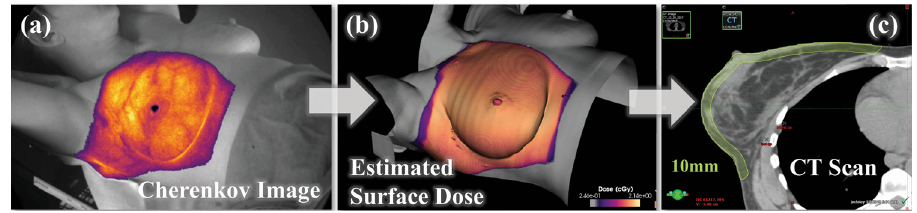
Fig. 2 Model to build correction factors. Cherenkov frames are recorded throughout a fraction of treatment and summed into a cumulative image ( a ). Each beam was then separated out by beam energy and gantry angle. Each Cherenkov image is divided by the respective co-registered surface dose image ( b ) rendered in C-Dose software from the treatment plan (Supplementary Fig. 1). The patient planning CT scan is then sampled down up to 10 mm for an average CT attenuation number (HU) ( c ), done in the treatment planning software by creating a structure (contour pictured). A correction factor is calculated from both average CT attenuation and Cherenkov normalized by dose. In an ideal scenario, the corrected Cherenkov image corrects for tissue optical properties and shares a higher metric of uniformity with the surface dose image ( b ).